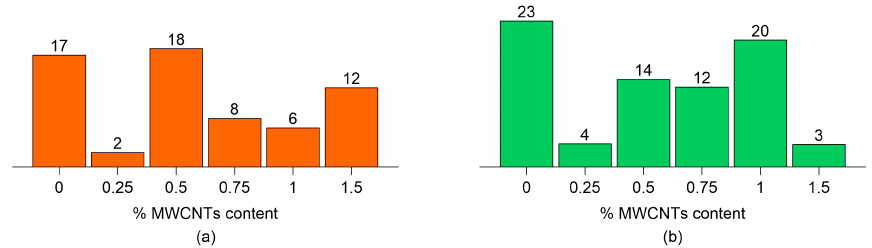
Figure 7. Gauge factor as a function of MWCNT content for ( a ) cured paste specimens; and ( b ) concrete specimens.